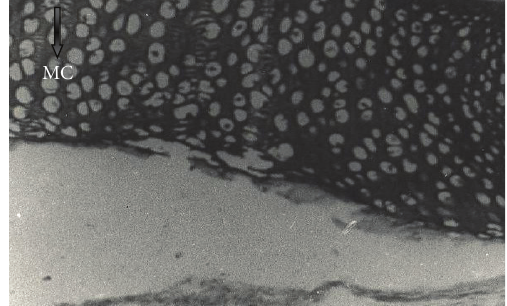
Figure 6: Plate of photomicrograph of gill of Clarias gariepinus after 12 weeks of exposure to 25ppb of gammalin 20 showed numerous mucus cells (MCs), distortion, separation of the layers, and sloughing.